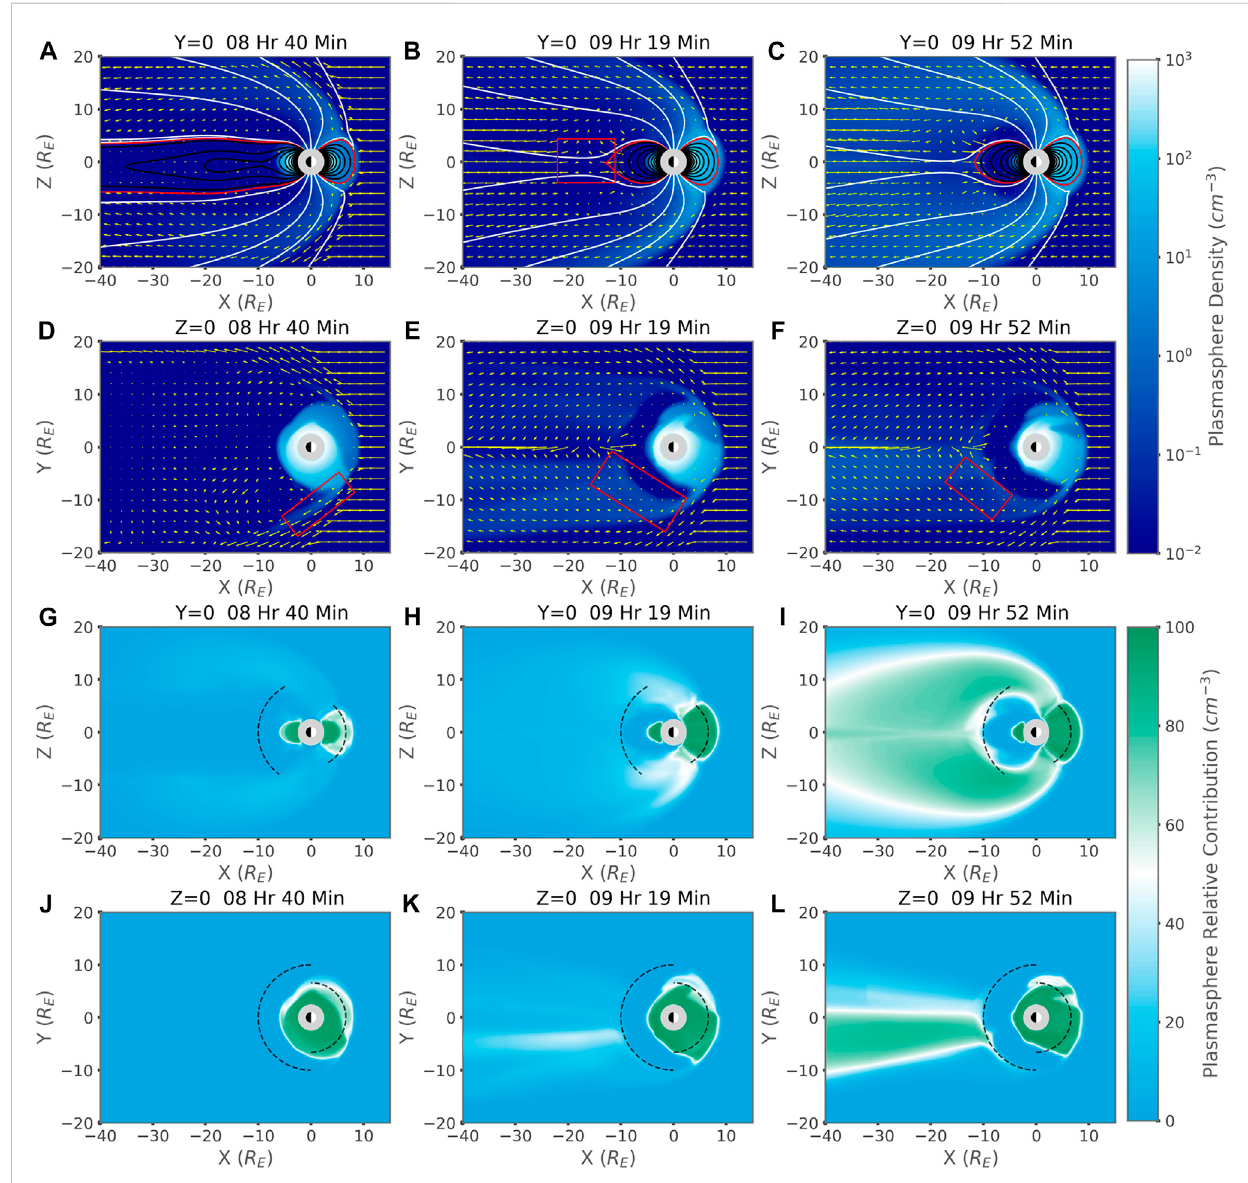
FIGURE 3 FromtheBATS-R-US simulationoftheIdealSquareWaveEvent.Column (A) :8Hrand 40Minintothesimulationjustastheplume arrivesatdayside reconnection.Column (B) :9Hr19Minintothesimulation,whenthereisaboutequalrecirculationaroundthe fl anksandoverthepoles.Column (C) :9Hr 52 Min into the simulation, at the period of maximum relative contribution of the plasmasphere to total fl uence across the night side measurement boundary 1. (A) – (F) State of the Plasmasphere at three key times of the Ideal Square Wave Event. The color map corresponds to the density of the plasmasphere fl uid in BATS-R-US, while the yellow vector fi eld represents the velocity of the same fl uid. (A – C) Y = 0 slices additionally showing the magnetic fi eldcon fi guration. White curvesareopen magnetic fi eld lines, redisthelast closed fi eldline, while blackcurvesrepresenttheclosed magnetic fi eld. (D – F) Z = 0 slices. (G – L) Relative contribution of the plasmasphere fl uid to the total fl uid density. A contribution of 0% means that there is no contributiontothetotaldensityfromtheplasmasphere fl uid.Acontributionof50%meansthatthecombinedsolarandpolarwind fl uidcontributestothe totaldensity equally with theplasmasphere fl uid.A contribution of 100%meansthat there isno contributionto thetotal density from thecombinedsolar and polar wind. The color map is scaled so that white occurs at 50%. The Black dashed circular arcs mark the where the surface of measurement crosses through the Y = 0 and Z = 0 planes 1. (G – I) Y = 0 slices, (J – L) Z = 0